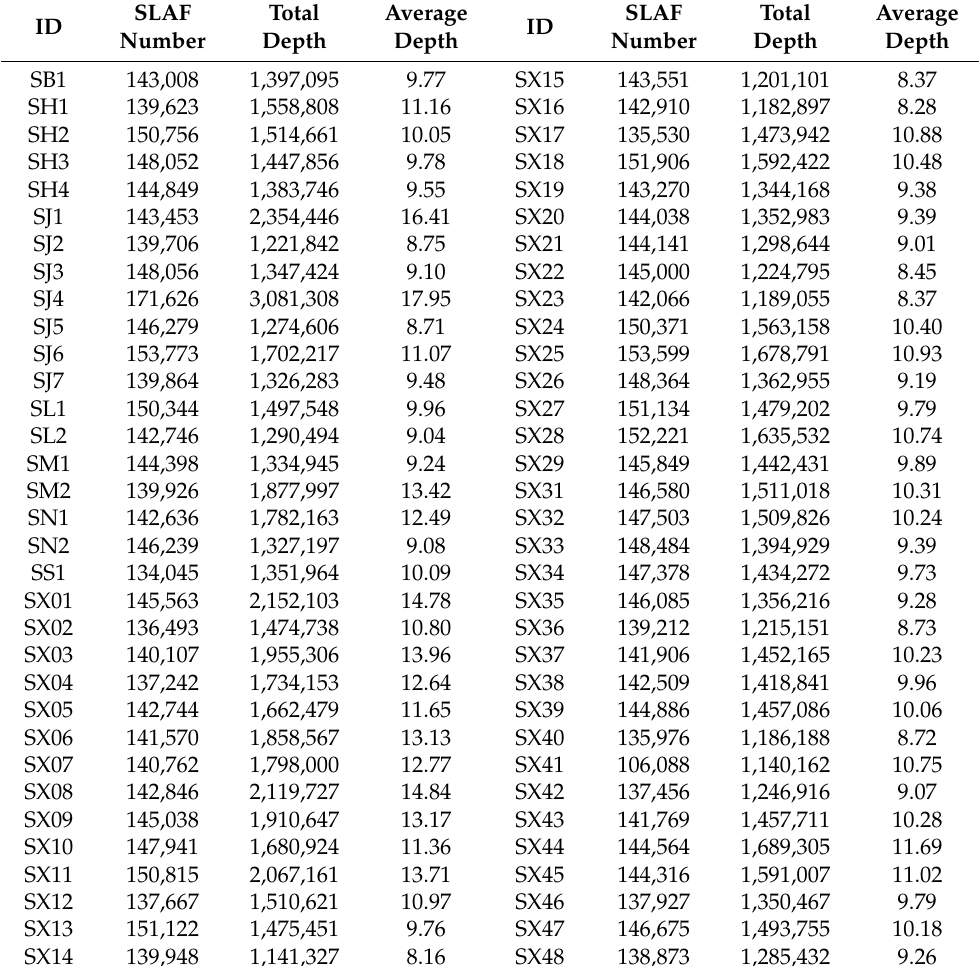
Table 3. Summary statistics for specific-locus amplified fragment sequence